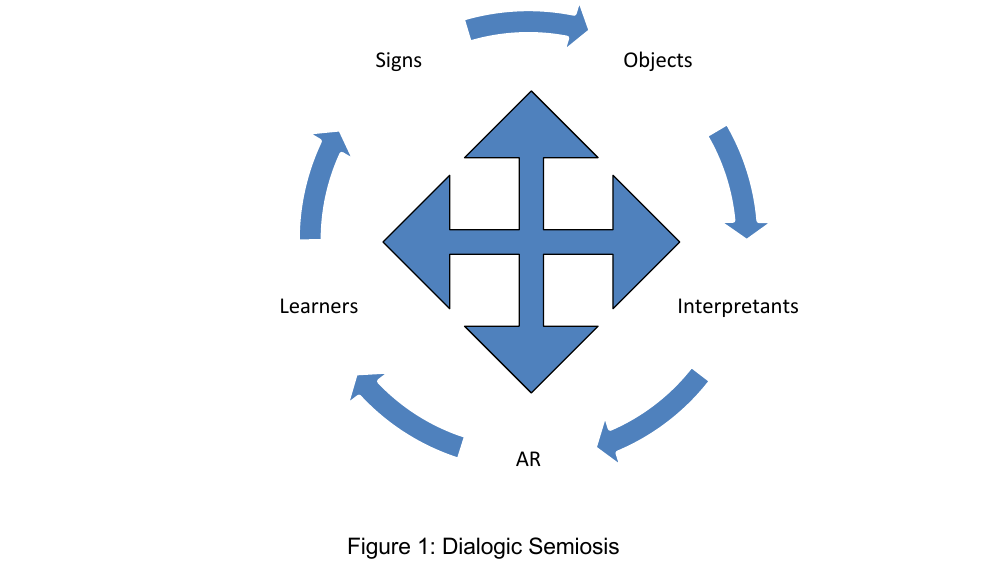
Interpretants ARLearners